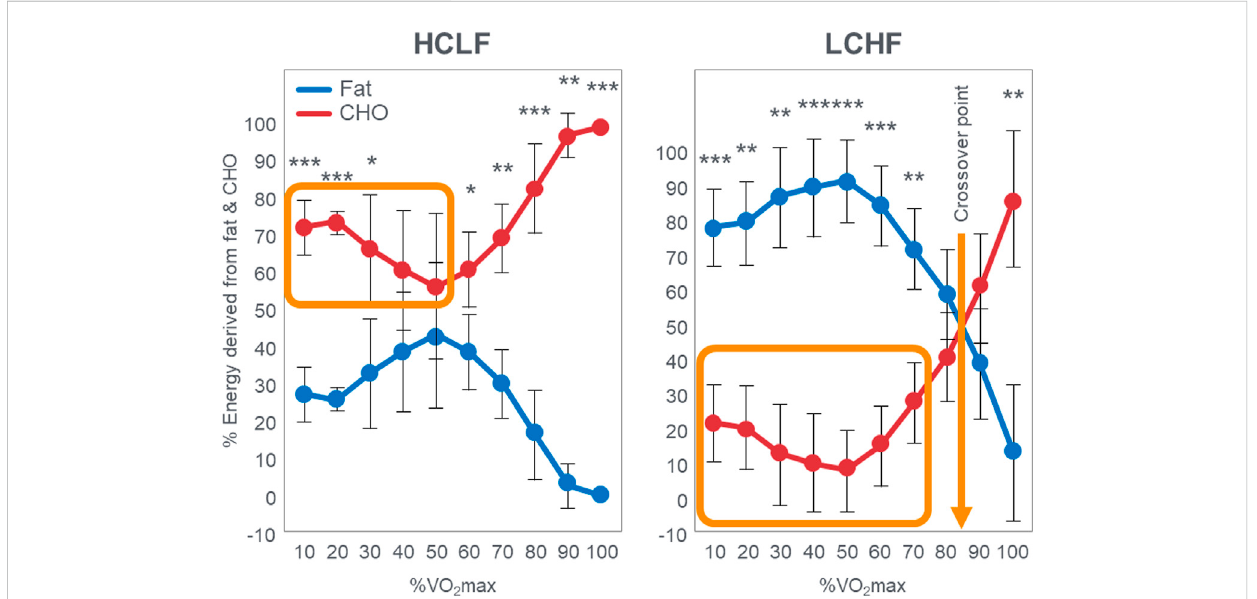
FIGURE 3 Relative contribution (%) of carbohydrate and fat to energy expenditure during exercise across a range of intensities in response to consuming a HCLF(leftpanel)orLCHF(rightpanel)dietfor6 weeks.Leftpanel;energyexpenditureonHCLFdiet;Rightpanel;energyexpenditureonLCHFdiet, n =7. Data: Mean ± SD. * p < 0.05, ** p < 0.01, *** p < 0.001, signi fi cant difference between LCHF and HCLF. This is reproduced from reference (Prins et al., 2023b). The orange box in the left panel indicates high rates of carbohydrate oxidation at low exercise intensities with no obvious crossover point when following the HCLF diet. In contrast rates of carbohydrate oxidation are low when following the LCHF diet (orange box in right panel) and there is a clear crossover point at about 85%VO 2 max (arrow). Redrawn from reference (Prins et al.,